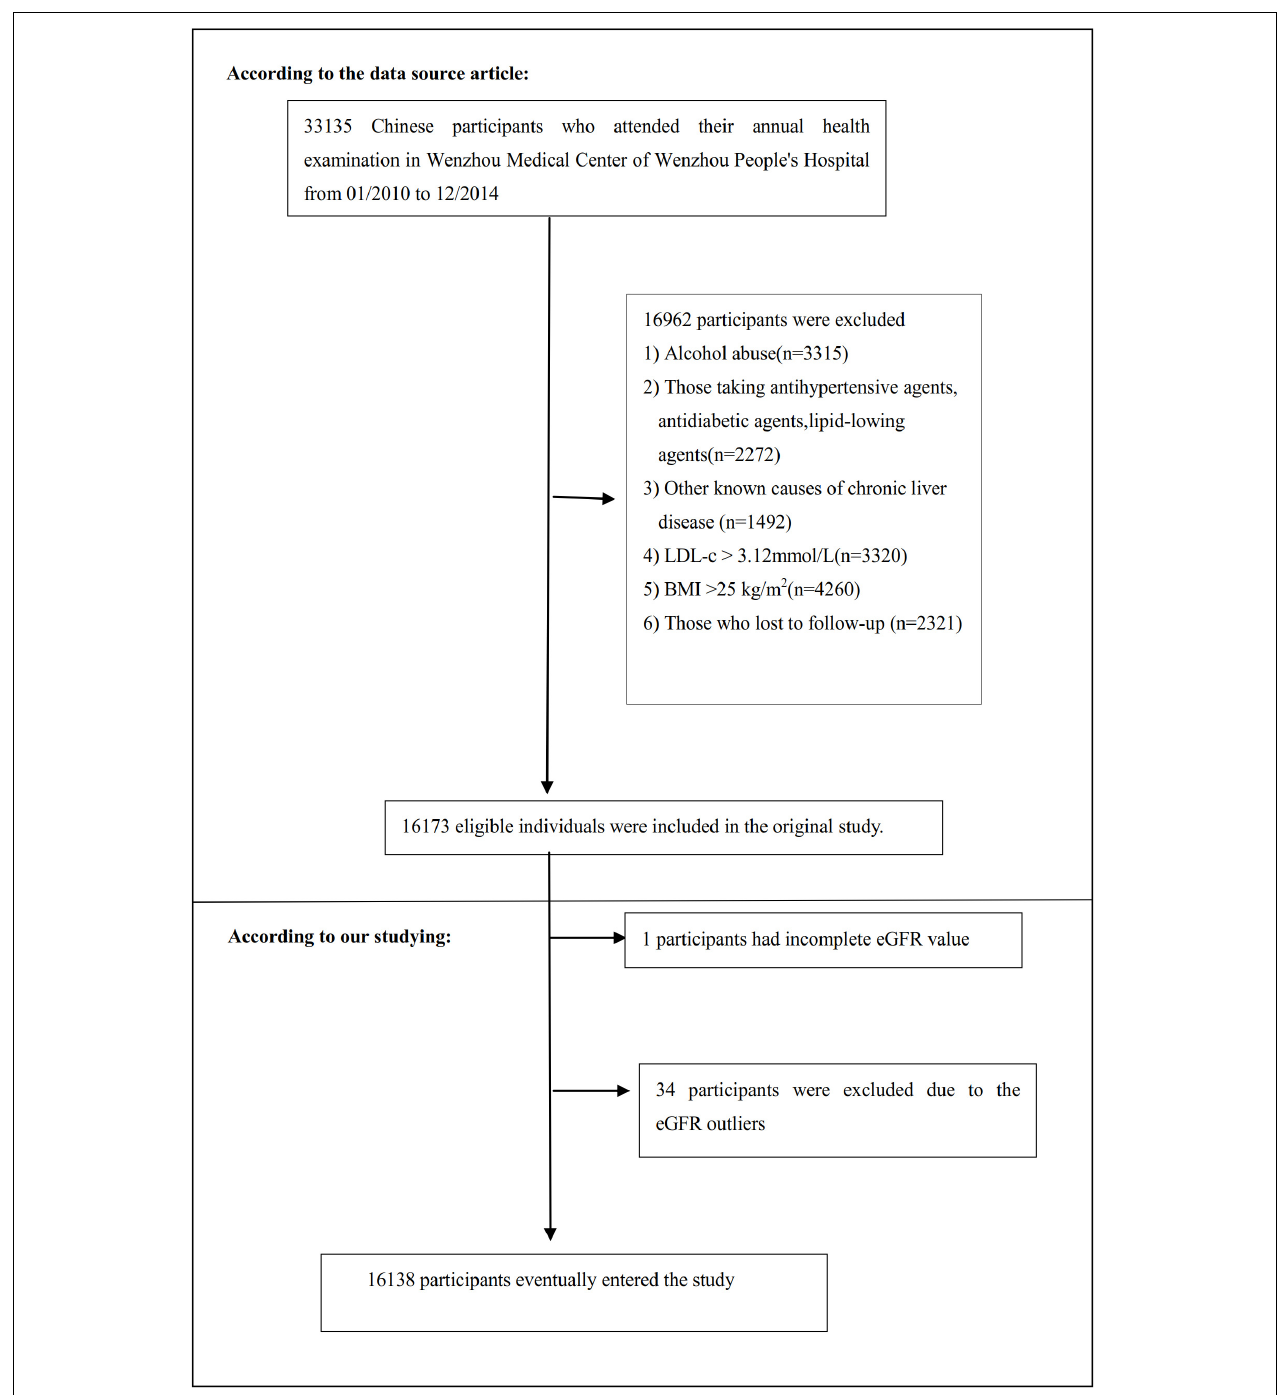
FIGURE 1 | Flowchart of study participants. This figure showed the inclusion of participants. 16,173 participants were assessed for eligibility in the original study. We excluded patients with missing values of eGFR ( n = 1), and outliers of eGFR ( n = 34). The final analysis included 16,138 subjects in the present study.